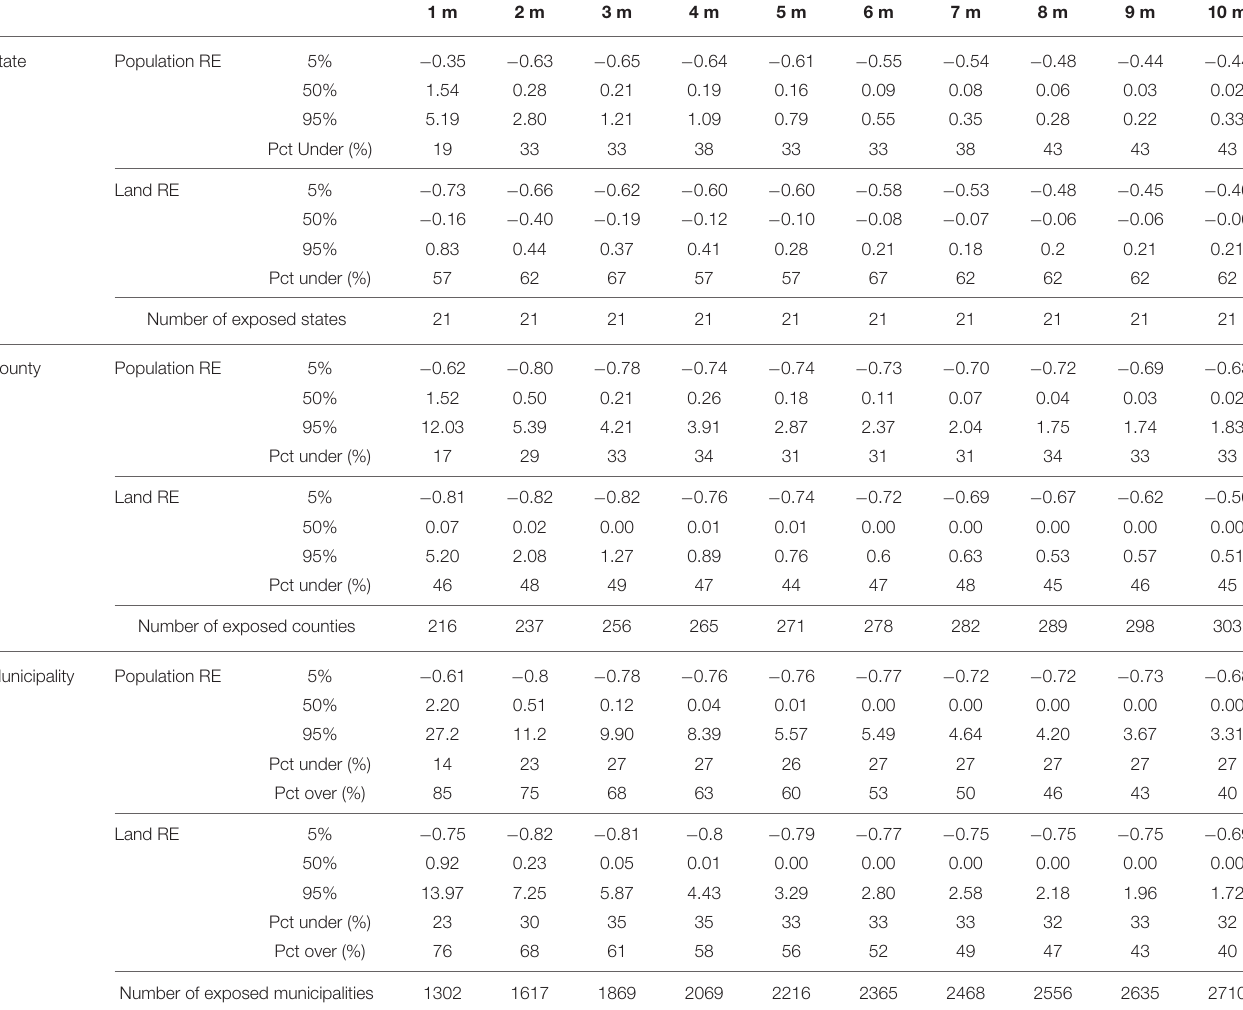
TABLE 2 | Relative error values at the 5/50/95th percentiles across exposed states, counties, and towns under